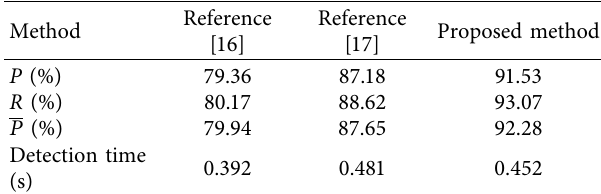
Figure 9: Partial test results of substation equipment. (a) Insulator damage. (b) Respirator damage. Table 2: Evaluation results of diferent